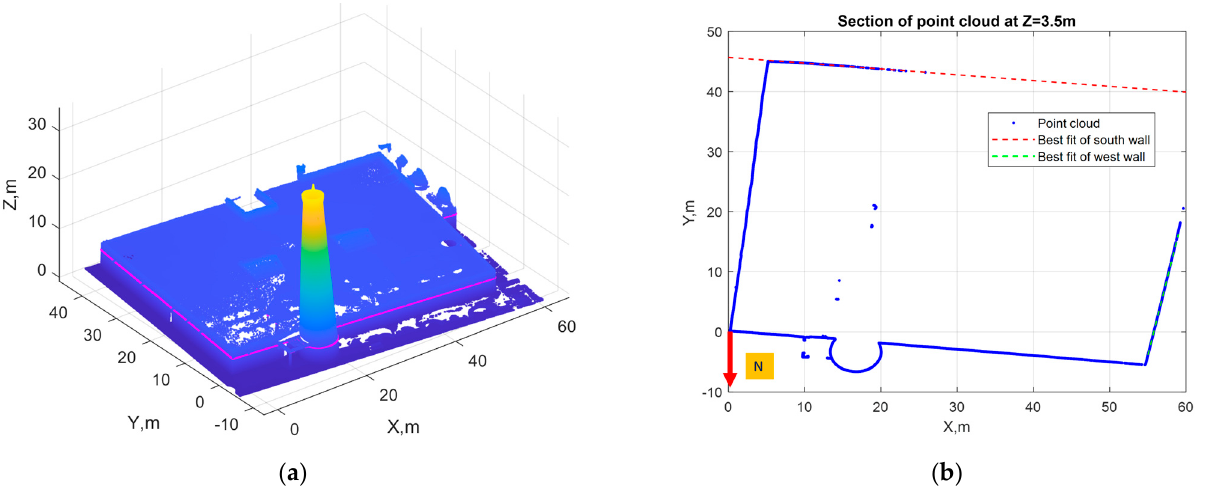
Figure 4. Point cloud of the minaret, adjusted for the global orientation of the walls: ( a ) point cloud with a horizontal section shown in magenta; ( b ) plan view of the horizontal slice at an elevation of 3.5